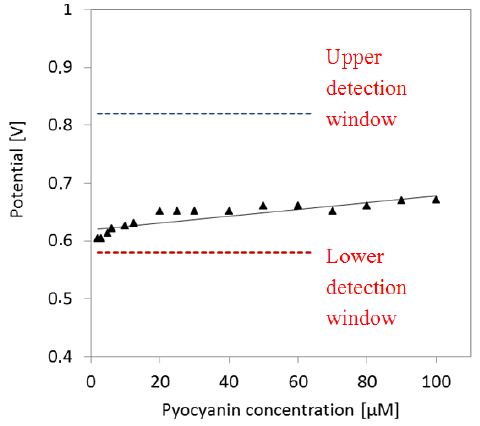
Figure 6. Peak potential as function of pyocyanin concentration. The potential peaks go towards the lower detection window of pyocyanin as the pyocyanin concentration decreases.